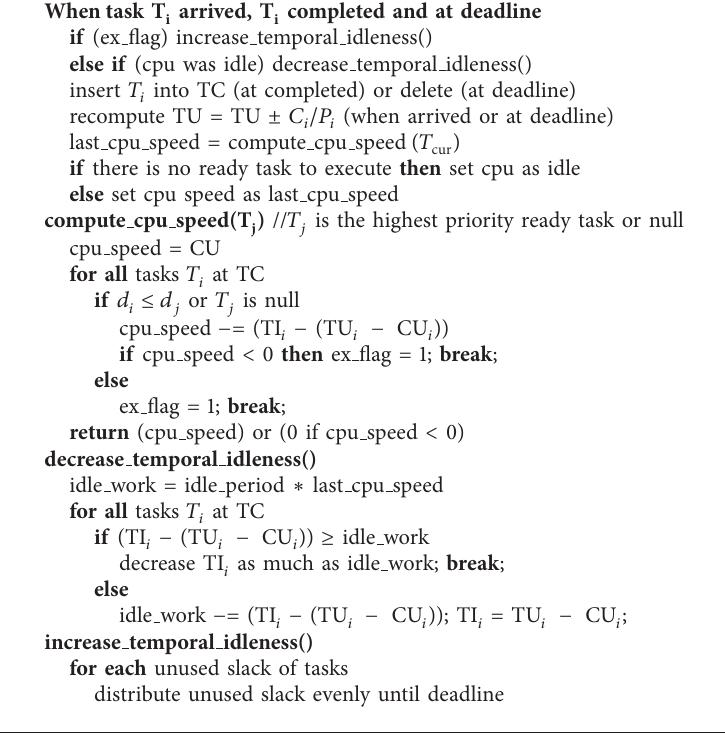
Algorithm 1: A power-aware scheduling algorithm.